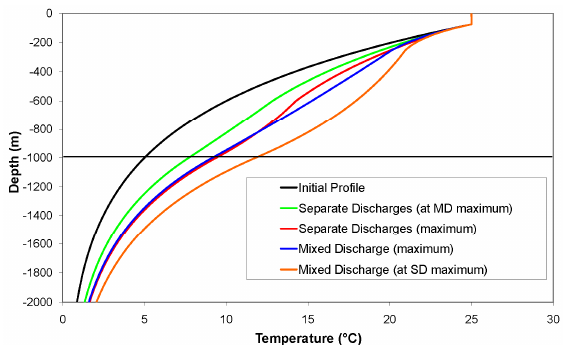
Figure 4. Seawater temperature profiles without OTEC (Initial Profile), and with OTEC under baseline (initial neutral buoyancy) effluent discharge scenarios: Separate Discharges (SD) or Mixed Discharge (MD); ‘maximum’ refers to the cold seawater flow w cw at which OTEC net power peaks.